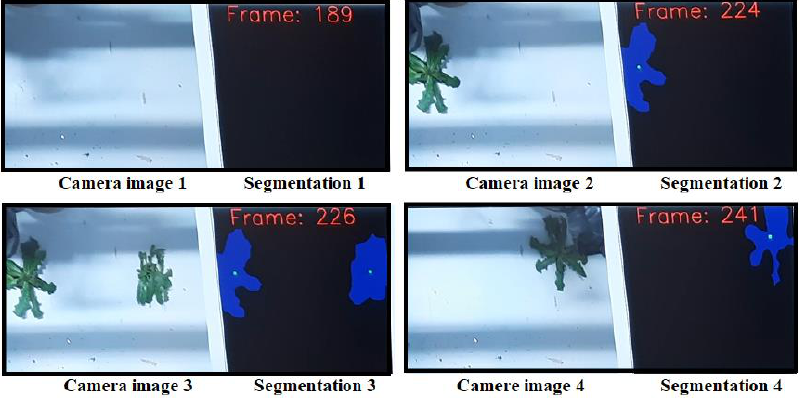
Figure 8. CWFID and weeds dataset qualitative segmentation results. Except for input and ground truth, the labels of each sub-image indicate the optimization that was applied to the model to produce the segmentation [32]. ( a ) Input; ( b ) Ground truth; ( c ) OS:8/dm:1.0; ( d ) OS:16/dm:1.0; ( e ) OS:32/dm:1.0; ( f ) Input; ( g ) Ground truth; ( h ) OS:8/dm:0.5; ( i ) OS:16/dm:0.5; ( j ) OS:32/dm:0.5.